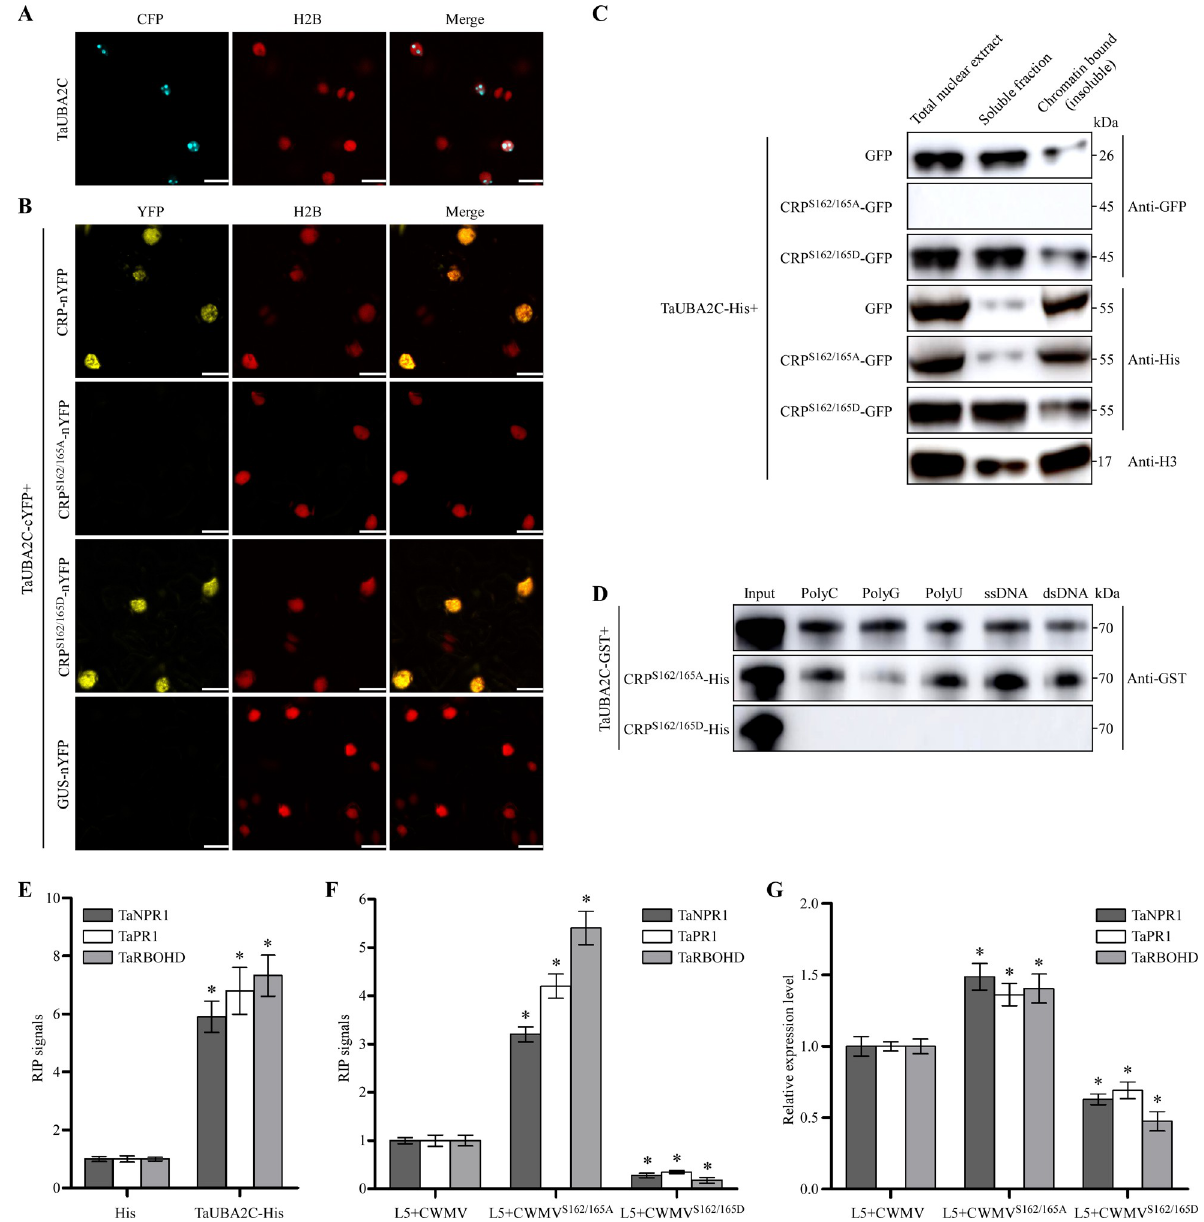
Fig 8. Phosphorylated CRP can interfere TaUBA2C RNA and DNA binding activities. A. Subcellular localization of TaUBA2C-CFP in H2B-RFP transgenic N . benthamiana plants epidermal cells. Confocal images were taken at 60 h post infiltration (hpi). Scale bar = 20 μ m. B. Analysis of subcellular localization of the co-expressed TaUBA2C-cYFP and CRP-nYFP, TaUBA2C-cYFP and CRP S162/165A -nYFP, TaUBA2C-cYFP and CRP S162/165D -nYFP, and TaUBA2C-cYFP and GUS-cYFP, respectively, in H2B-RFP transgenic N . benthamiana leaves through BiFC assay. Confocal images were taken at 60 hpi. Scale bar = 20 μ m. C. Western blot analyses of subcellular localizations of the co-expressed TaUBA2C-His and GFP, TaUBA2C-His and CRP S162/165A -GFP, or TaUBA2C-His and CRP S162/165D -GFP using an anti-GFP or an anti-His antibody. Histone H3 protein was used as a chromatin-bound protein marker. D. RNA and DNA binding activity assays. TaUBA2C-GST, CRP S162/165A -His and CRP S162/165D -His were individually expressed and purified. The purified TaUBA2C-GST was first mixed with CRP S162/165A -His or CRP S162/165D -His, and then mixed with polycytidylic [poly(rC)], polyguanylic [poly(rG)], polyuridylic [poly(rU)], single-stranded DNA or double-stranded DNA. After incubation, these samples were analyzed through western blot assays using an anti-GST antibody. E. RIP-RT-qPCR showing the enrichment of TaNPR1 , TaPR1 and TaRBOHD pre-mRNA on protoplasts expressing TaUBA2C-His. The protoplasts expressing His were used as negative controls. RIP signals were presented as the percentage of immunoprecipitated TaNPR1 , TaPR1 and TaRBOHD pre-mRNA relative to input TaNPR1 , TaPR1 and TaRBOHD pre-mRNA. The data presented are the means ± SD, determined using the Student’s t -test. Each treatment had three biological replicates. � , P < 0.05. F. RIP-RT-qPCR showing the enrichment of TaNPR1 , TaPR1 and TaRBOHD pre-mRNA on TaUBA2C-His transgenic wheat seedlings infected with CWMV, CWMV S162/165A or CWMV S162/165D , respectively. The data presented are the means ± SD, determined using the Student’s t -test. Each